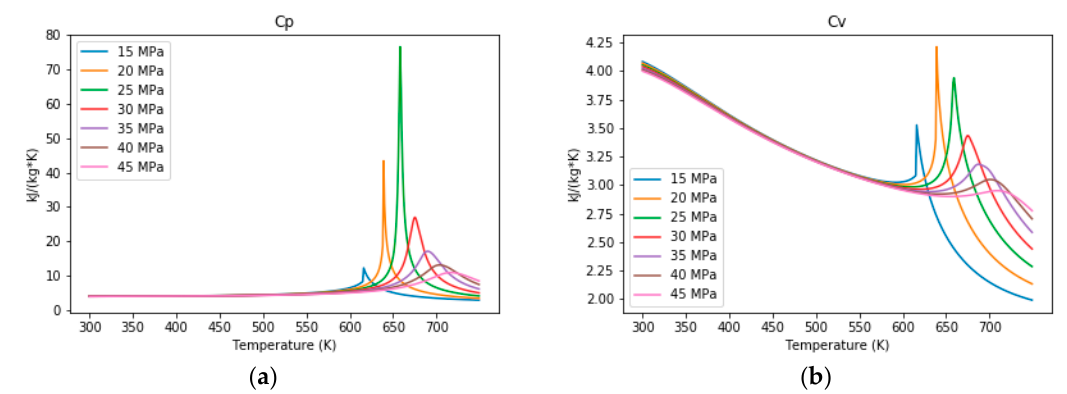
Figure 3. Values of specific heat capacities of water as a function of temperature at various pressures. The data points are taken from Wagner and Pruß [60]: ( a ) C p ; ( b ) C v .